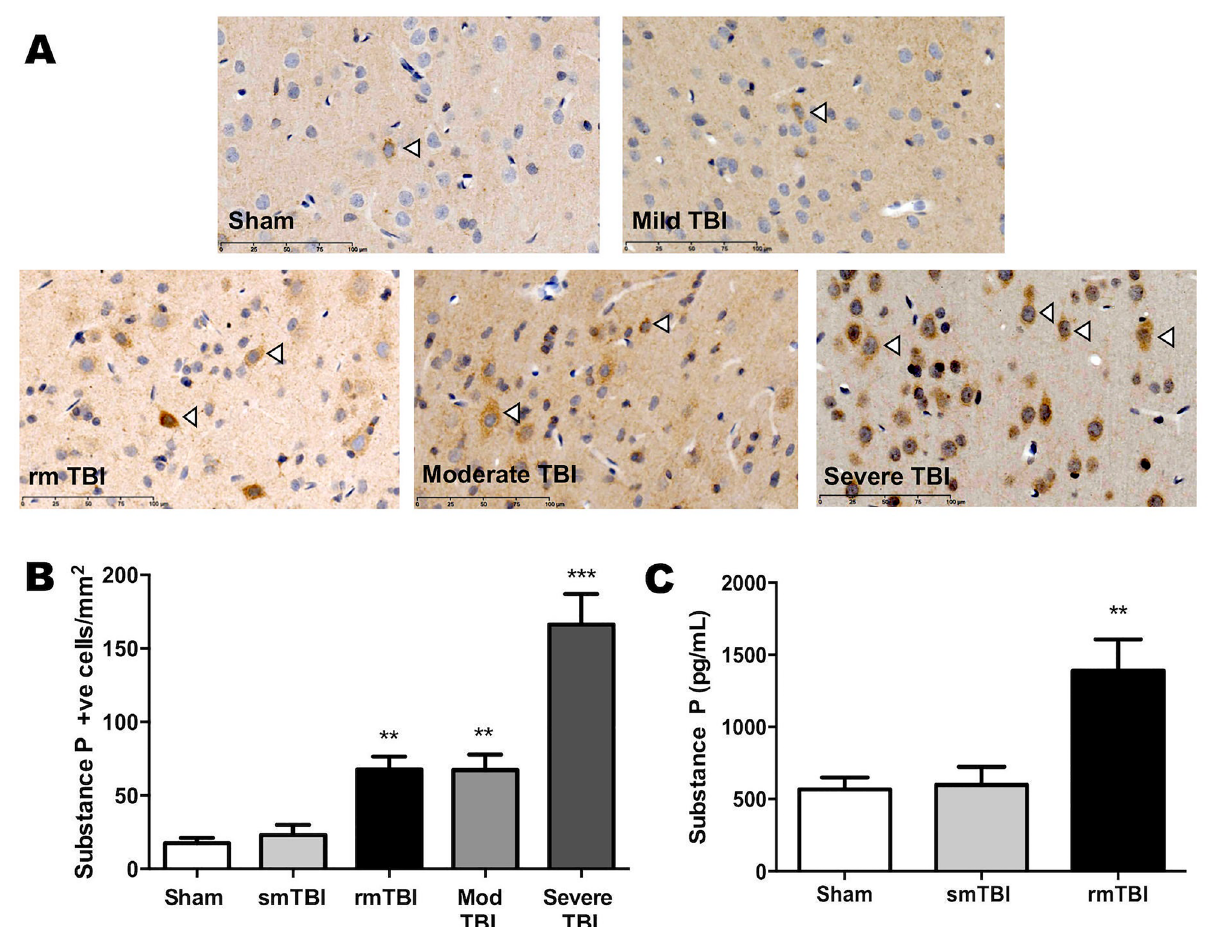
Figure 1. Increases in substance P immunoreactivity following diffuse TBI in rats. Immunohistochemistry (A) typically demonstrates the presence of substance P positive cortical neurons (arrowed) immediately below the impact site at 24 h after the final injury. While no significant increase was observed after a single mild TBI (smTBI), clear increases in substance P immunoreactivity were observed with increased intensity of the injury and with repeated exposure to the mild injury (rmTBI). Cell counts (B) and ELISA assay (C) confirm the immunohistochemistry findings. Mean ± SEM; n = 5–8/group; ** = p < 0.01, *** = p < 0.001 versus sham and